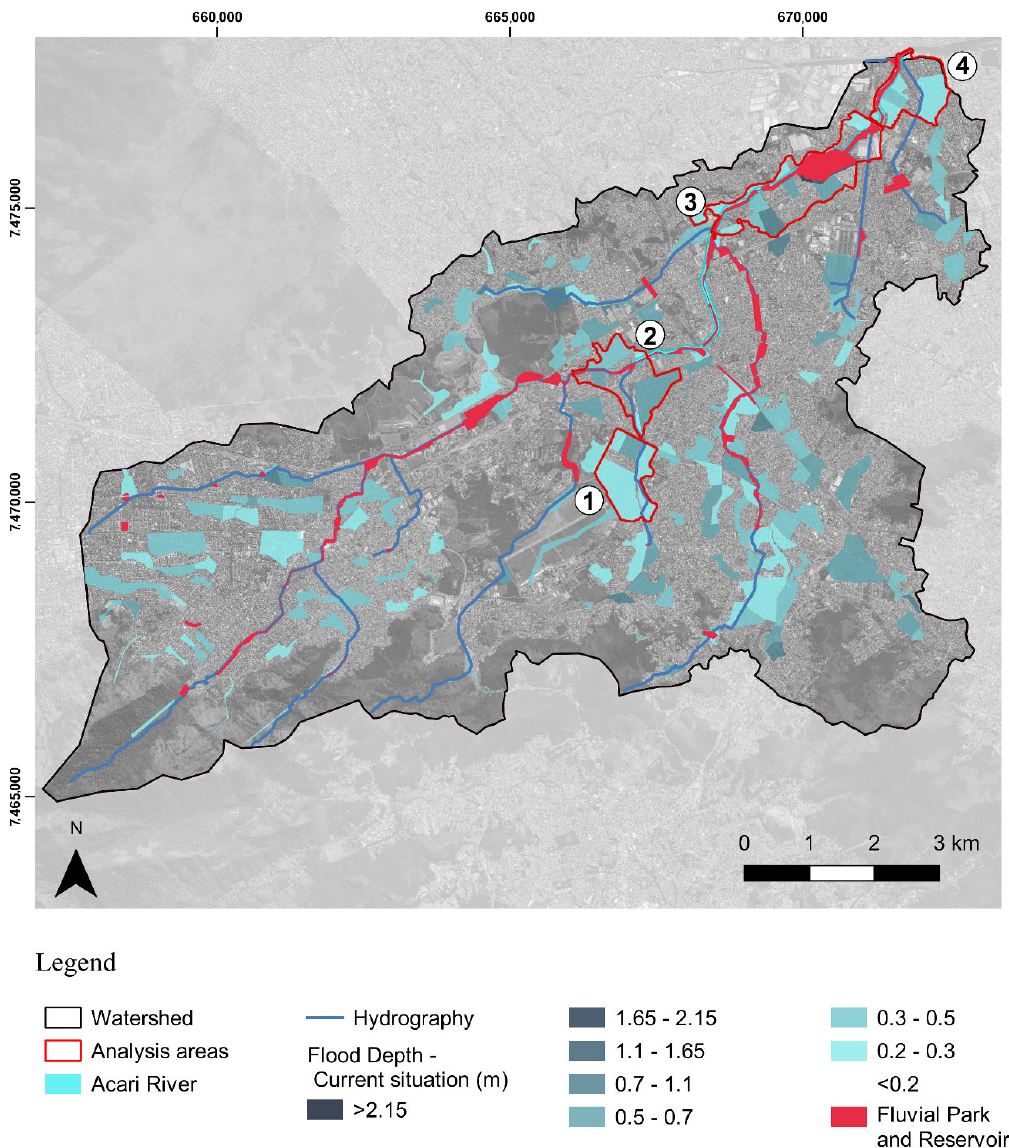
Figure 10. Flood Map—Design scenario—return period of 25 years. The figure shows the flood depths separated into 8 flooding ranges.